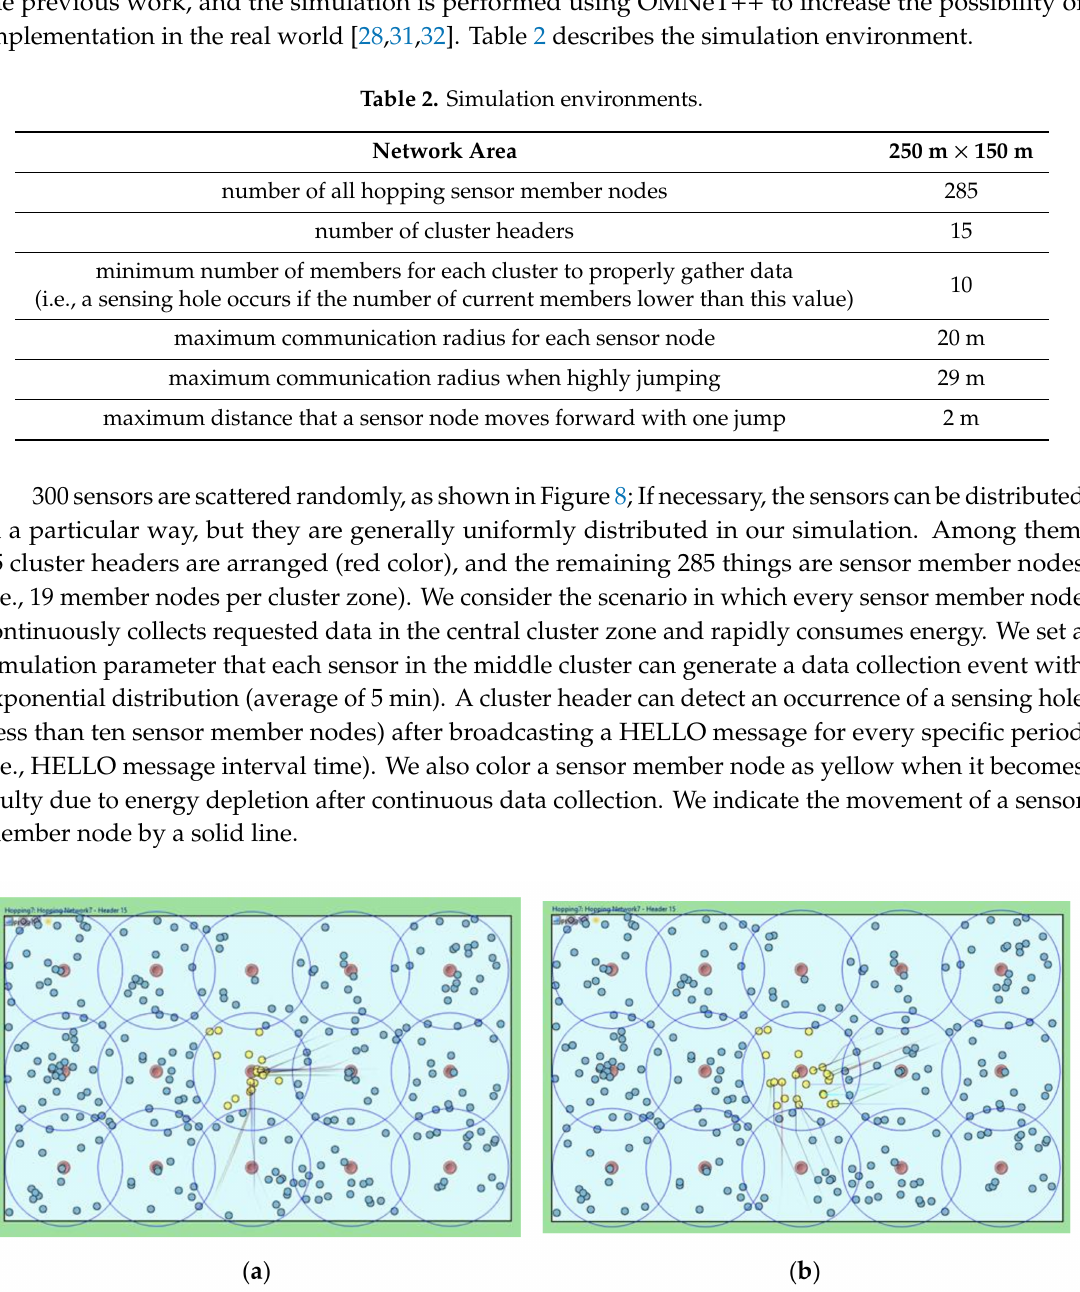
Figure 8. Simulation snapshots of the movements of sensor member nodes. ( a ) Previous scheme; ( b ) Proposed